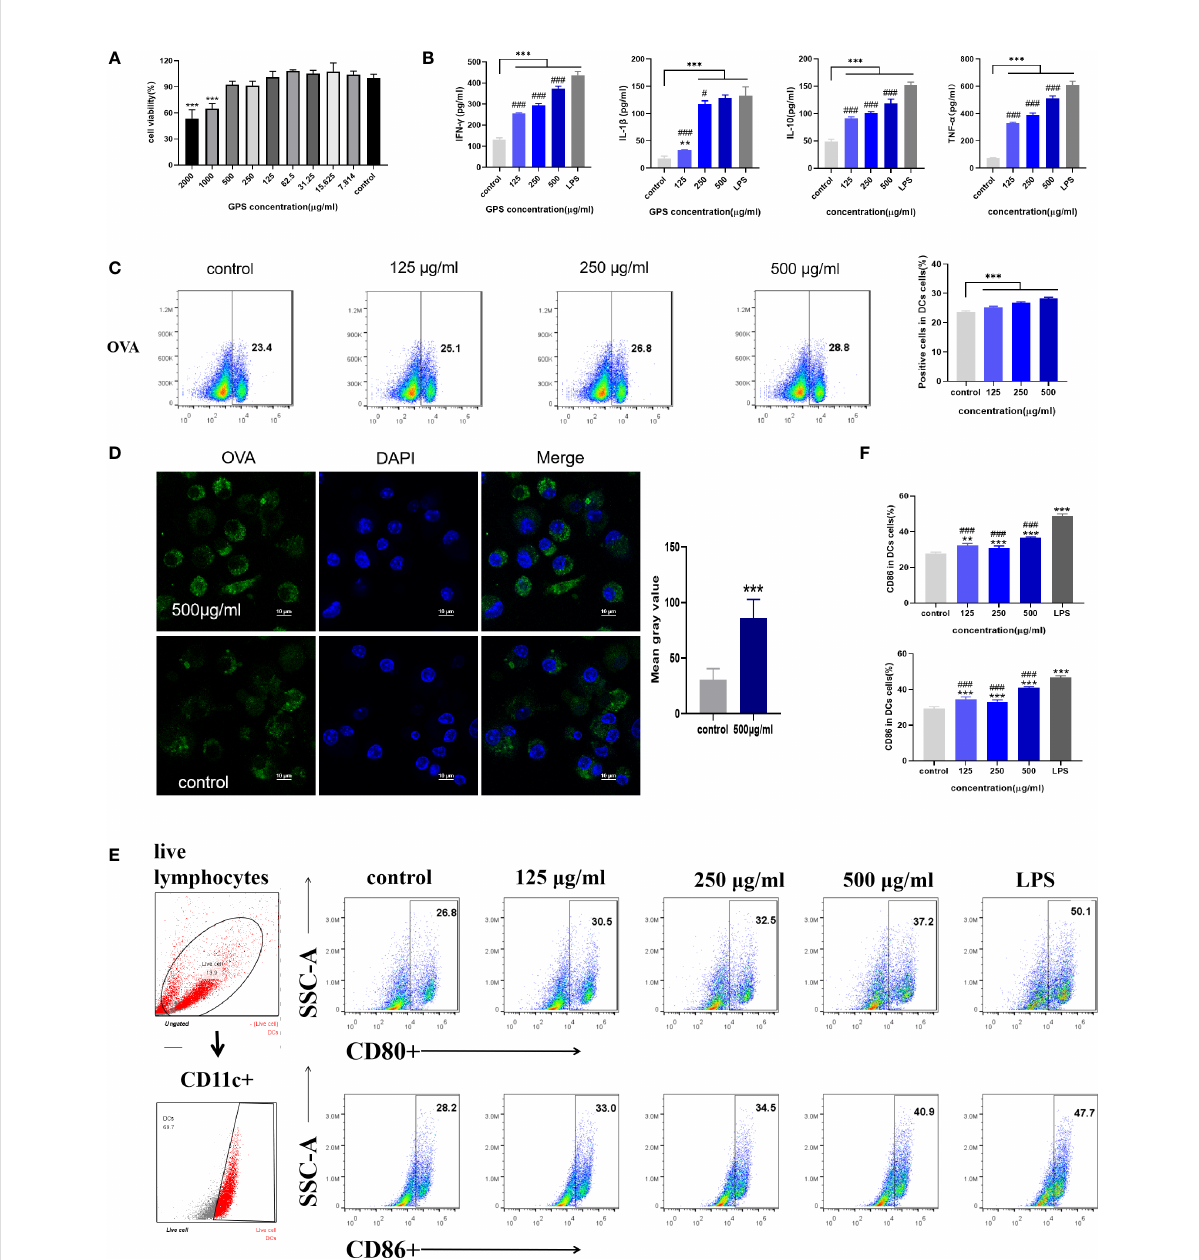
FIGURE 5 (A) The effect of GPS-1 on the activity of mouse DCs (n=6). (B) The effect of GPS-1 on cytokine secretion by DCs (n=4). (C) Flow cytometry and scatter diagram of GPS-1 enhancing the phagocytosis of DCs. (D) Confocal image of GPS-1 enhancing phagocytosis of DCs and statistics of fl uorescence intensity. (E) GPS-1 increases the expression of CD80 and CD86 on the surface of DCs and the scatter plot. (F) GPS-1 increases the expression of CD80 and CD86 on DCs surface fl ow statistics Compared with blank group (Control): **p<0.01, ***p<0.001; compared with positive control group (LPS): # P<0.05, ###